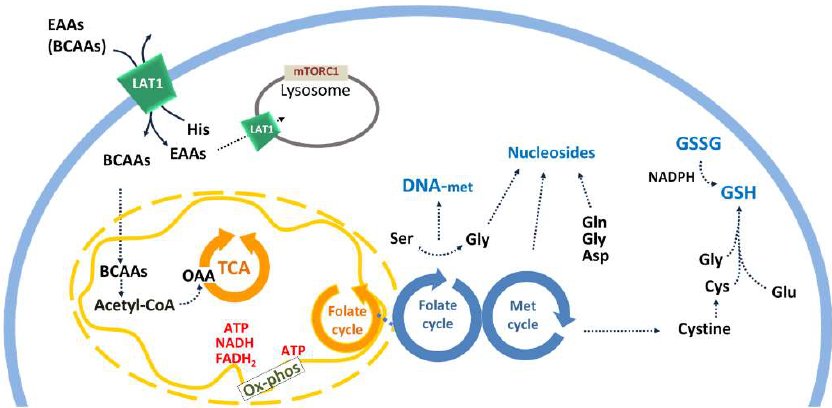
Figure 2. Schematic representation of specific pathways linked to LAT1 expression in cell membranes. LAT1 is represented in green in both plasma and lysosomal membranes. LAT1 mediates the exchange of nine EAAs (Essential Amino Acids), including BCAAs (Branched Chain Amino Acids), from external side of cell membrane, for internal histidine. Intermediates and amino acids (three letter codes) are represented in black; energetic substrates are depicted in red. Transport phenomena are represented by continuous arrows; enzyme pathways are represented by dotted arrows. Mitochondrial or cytosolic cyclic pathways are depicted in orange or blue, respectively. Lysosomes and mTORC1 are indicated in grey. TCA (tricarboxylic acid cycle), OAA (oxaloacetate), DNA-met (DNA methylation), GSH (reduced glutathione), GSSG (oxidized glutathione), ox-phos (oxidative phosphorylation), Met cycle (methionine cycle).